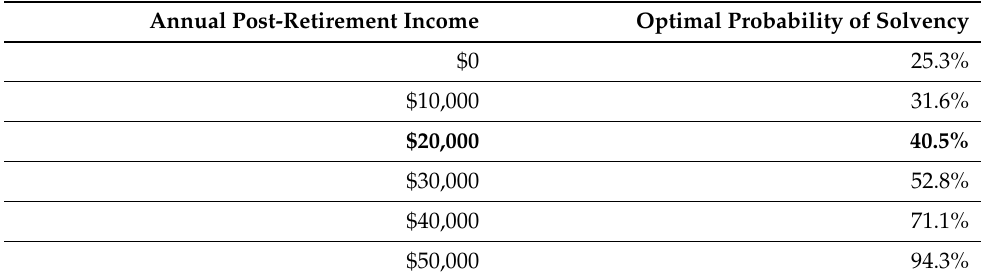
Table 13. The effect on Investor #2 of varying the post-retirement income, in t = 0 pre-tax dollars, from its normal value (in bold).